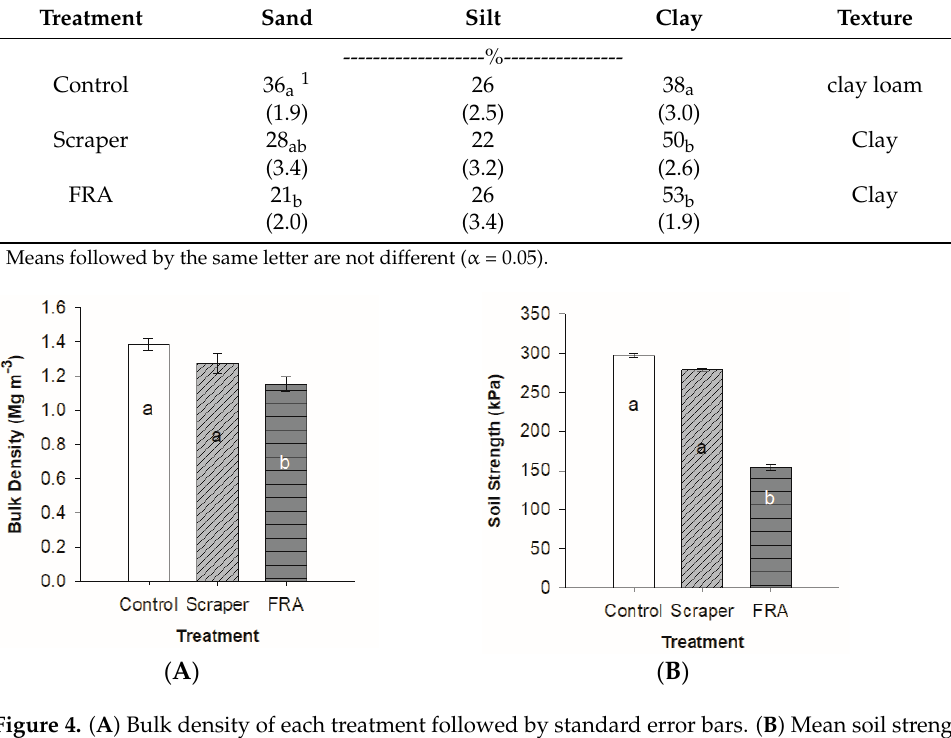
Table 2. Volumetric water concentration means by month in 2018 per treatment taken in conjunction with pressure chamber measurements.